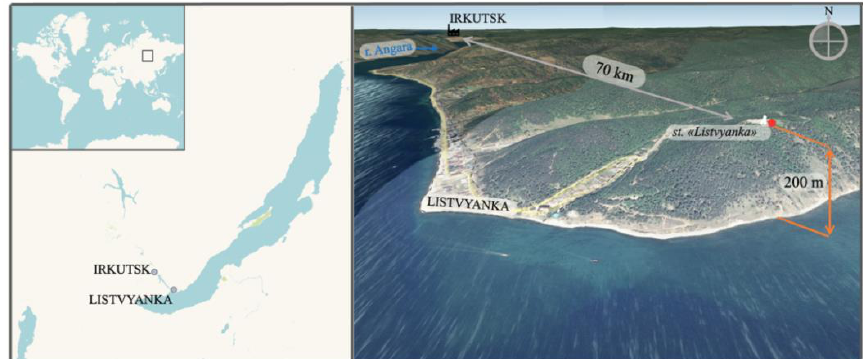
Figure 1. Schematic map of the layout of the stations for sampling aerosol for PAHs in the Southern Baikal region, Russia: the city of Irkutsk—urban area and the Listvyanka settlement—rural area.